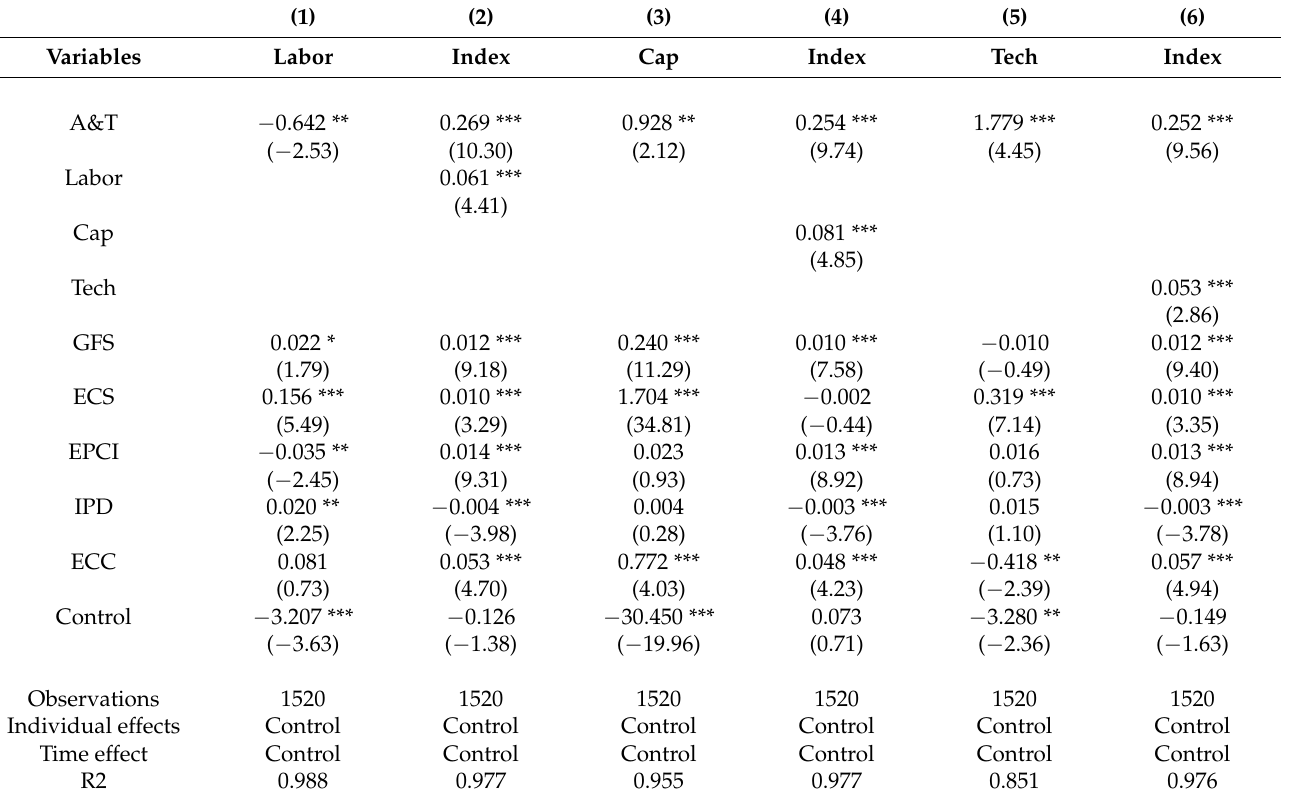
Table 5. Test of the transmission